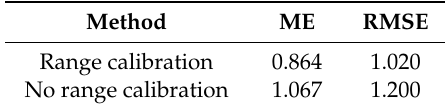
Table 1. The MEs and RMSEs of no range calibration /